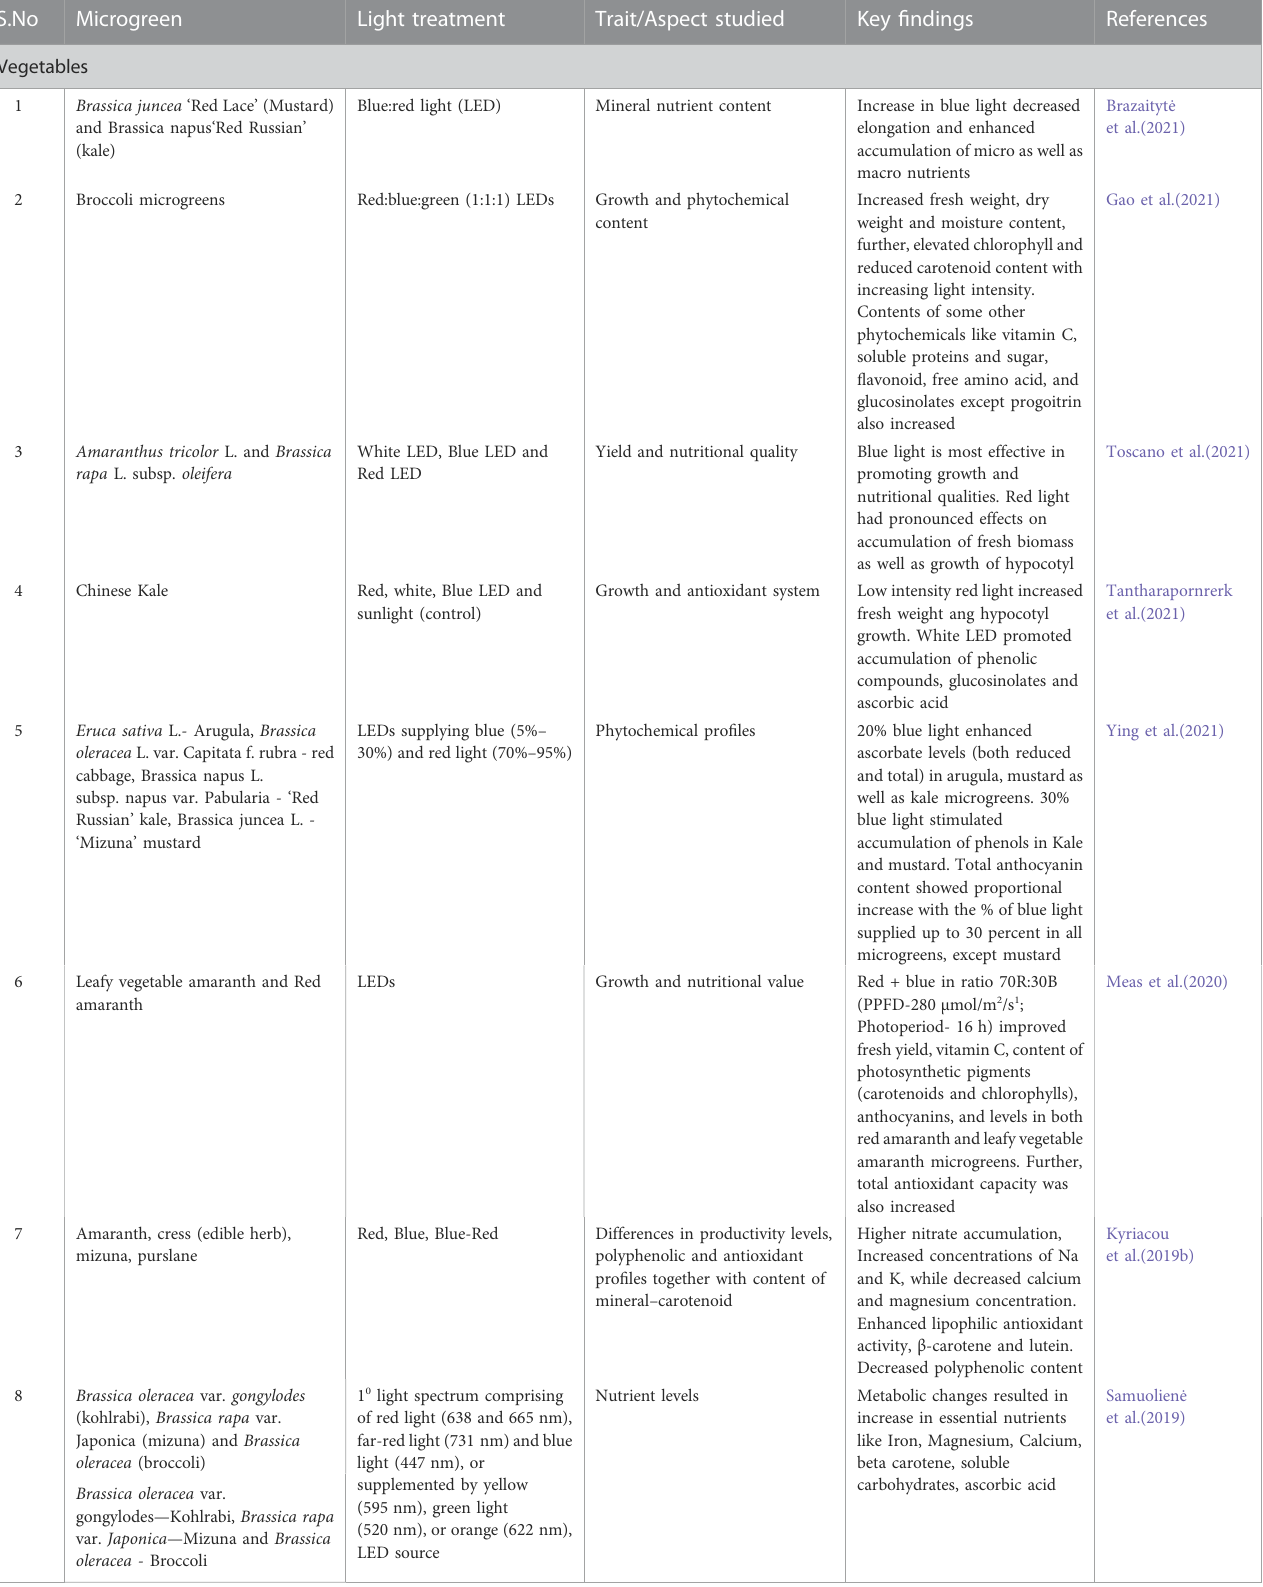
TABLE 4 In fl uence of light on growth and phytochemical quality of